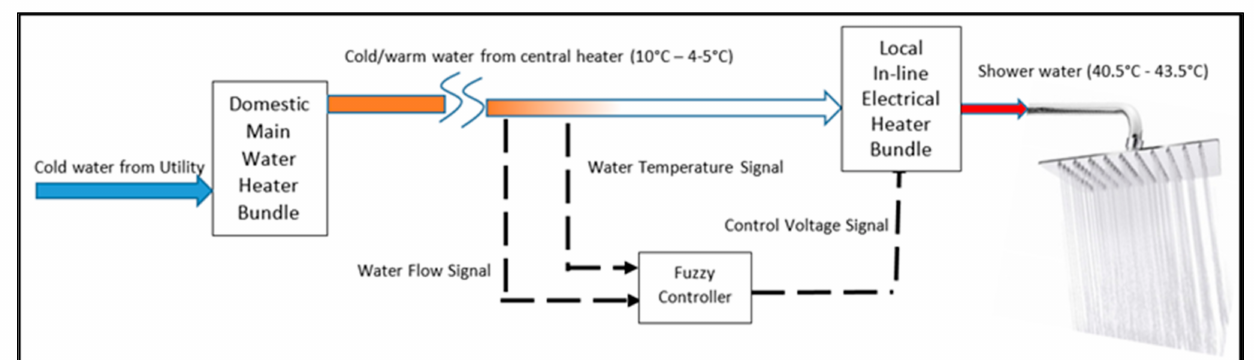
Figure 5. Block diagram for the proposed